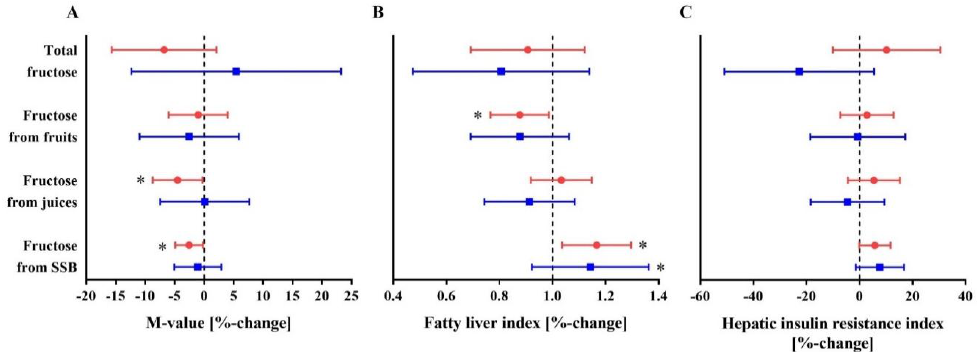
Figure 1. Association of sucrose plus non-sucrose bound total fructose, fructose from fruits, fruit juices and sugar-sweetened beverages with peripheral insulin sensitivity (M-value) ( A ), fatty liver index ( B ) and hepatic insulin resistance index ( C ) in patients with type 2 diabetes (T2D) and individuals without diabetes (CON). Data are summarized as relative changes, 95% confidence intervals ( A , C ) or odds ratios, 95% confidence intervals ( B ) and p -values from linear regression analyses, calculated using the M-value ( A ), the fatty liver index ( B ) and the hepatic insulin resistance index ( C ) as outcome variables. Total fructose as well as fructose from fruits, fruit juices and sugar-sweetened beverages were defined as exposure variables for linear regression analyses with fructose intake adjusted for the total daily energy intake [MJ] using the residual method. Red circles indicate individuals with type 2 diabetes, blue squares indicate individuals without diabetes (CON). * p < 0.05. Regression analyses are adjusted for total daily energy intake, age, BMI (not for models using fructose from SSB as independent variable), metabolic status, sex, the interaction term between metabolic status and sex, an interaction between subject group (T2D and CON) and fructose intake, leisure time physical activity and sports, marital status, highest school-leaving qualification, and current employment status. Relative changes (95% CI) ( A , C ) should be interpreted as follows: a doubling of fructose intake associates with a %-change of M-value ( A ), hepatic insulin resistance index ( C ) by the respective relative change. Odds ratios (95% CI) ( B ) should be interpreted as follows: a doubling of fructose intake associates with a change in the odds of having a fatty liver by the respective odds ratio. SSB, sugar-sweetened